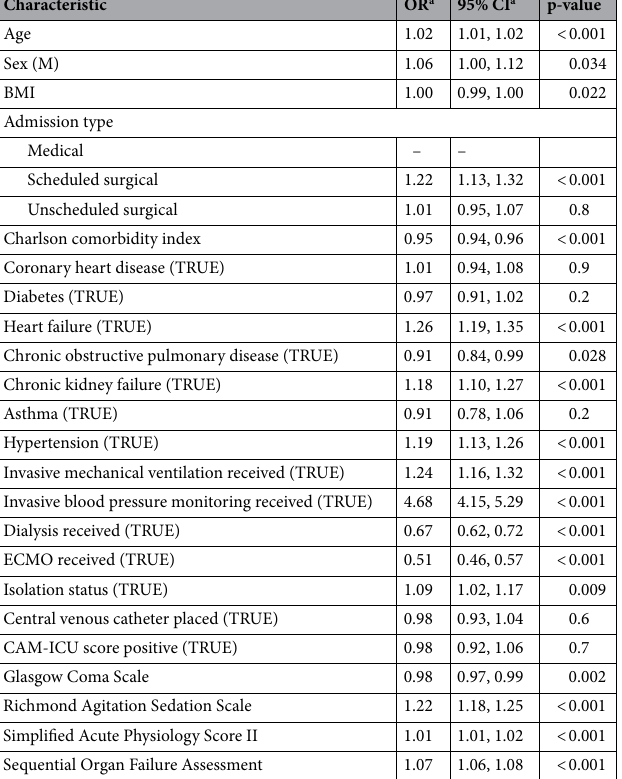
Table 2. Independent patient characteristics associated with a high alarm rate. BMI , body mass index; ECMO, extracorporeal membrane oxygenation; CAM-ICU , confusion assessment method for the ICU. a OR, odds ratio; CI, confidence